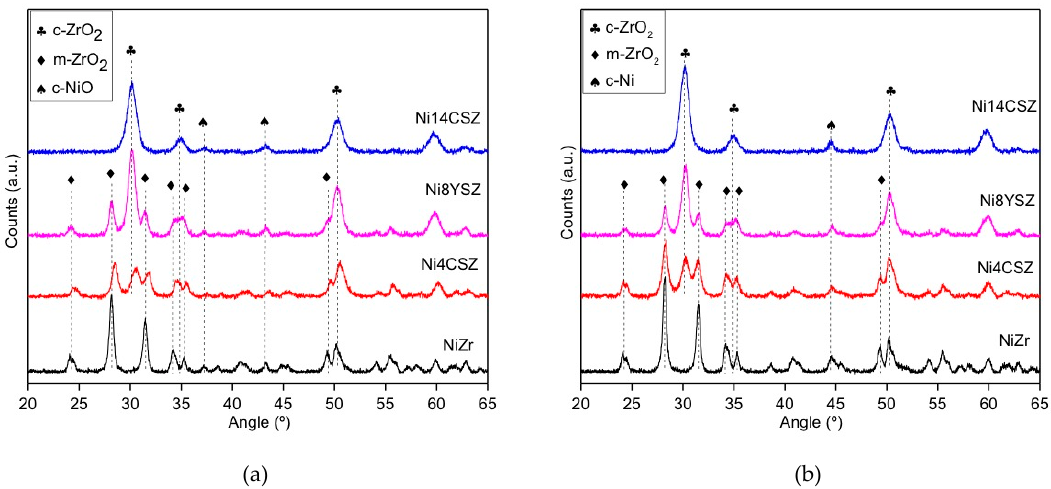
Figure 1. XRD patterns of the investigated catalysts (without Ce): ( a ) calcined; ( b ) reduced.